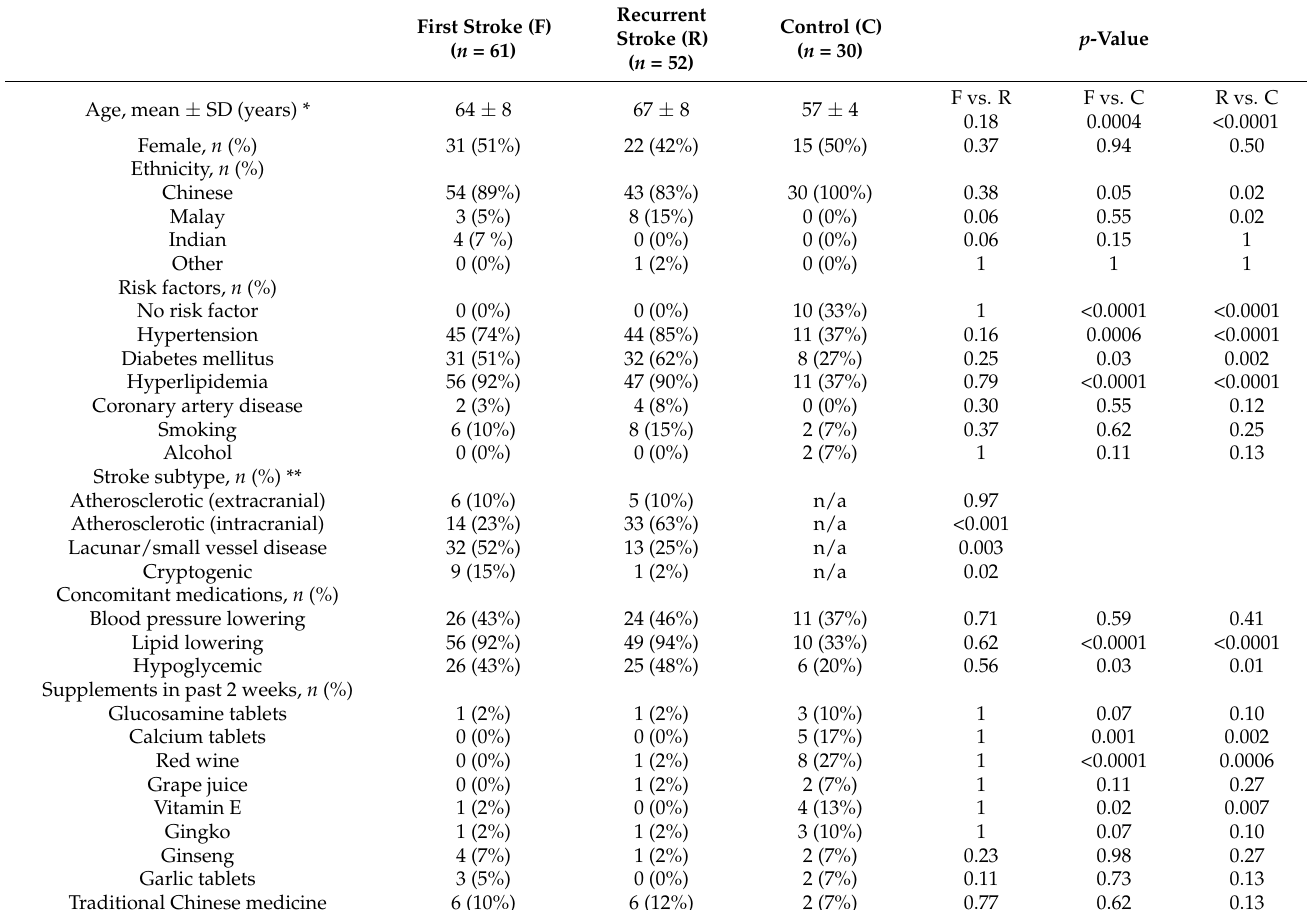
Table 1. Patient demographics according to stroke